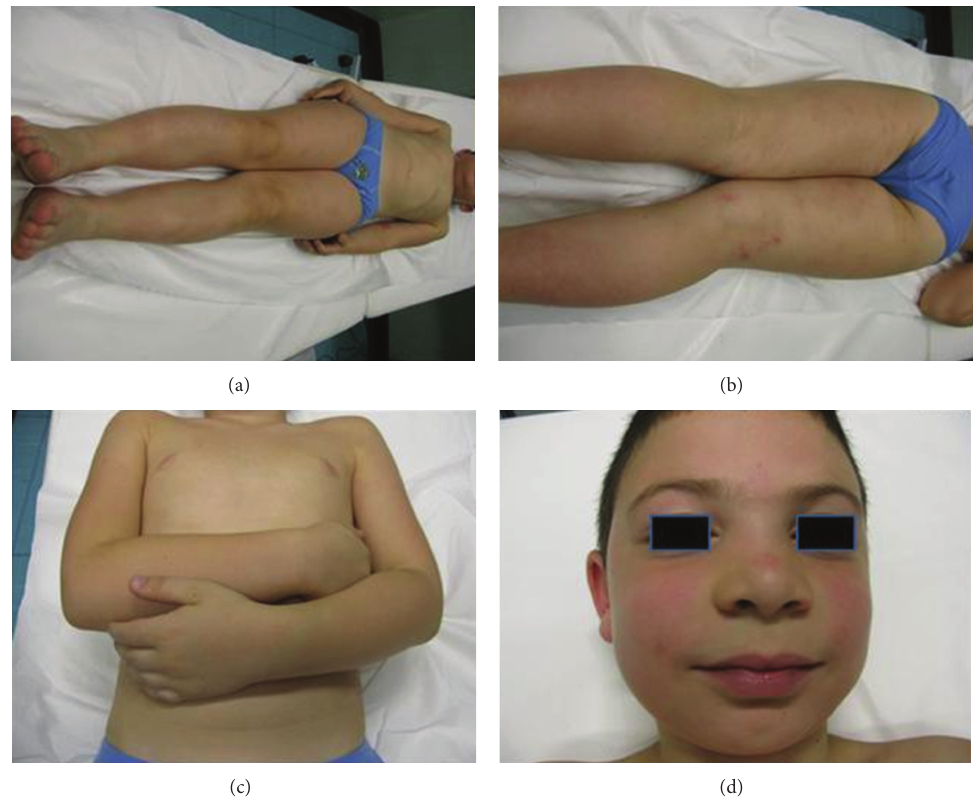
F 4: Followup at 2 weeks. e patient was treated with Dapsone. e cutaneous lesions were almost completely